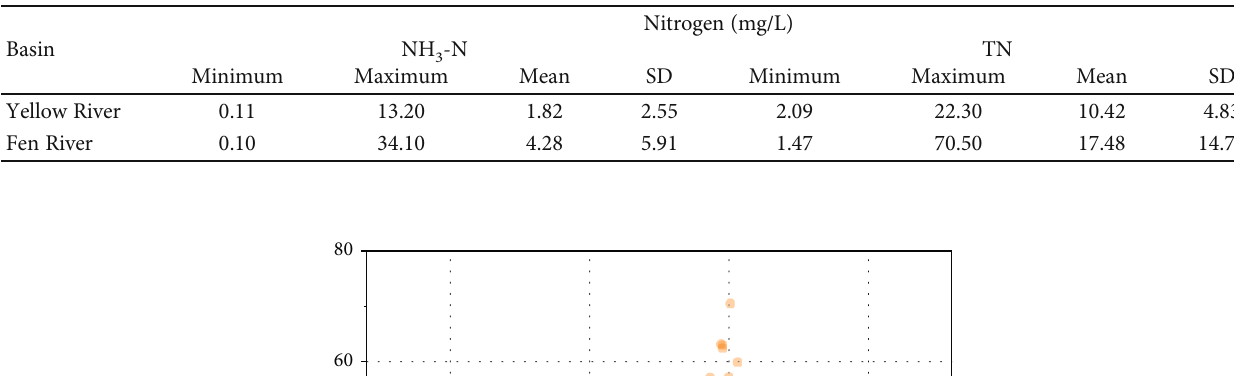
Table 1: Descriptive statistics of the nitrogen concentrations in Yellow River and Fen River Basins.